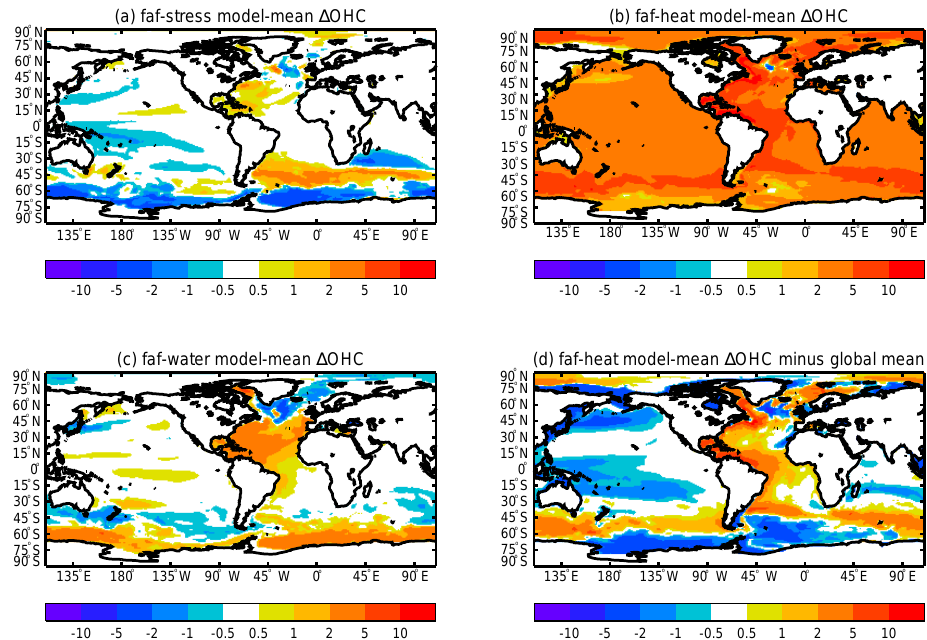
Figure 9. Model-mean change in ocean heat content (GJm − 2 , the vertical integral of the change in the ocean temperature θ multiplied by the volumetric heat capacity) in the time mean of the final decade of the FAFMIP experiments relative to the control. Panel (d) shows the field of (b) with its global mean